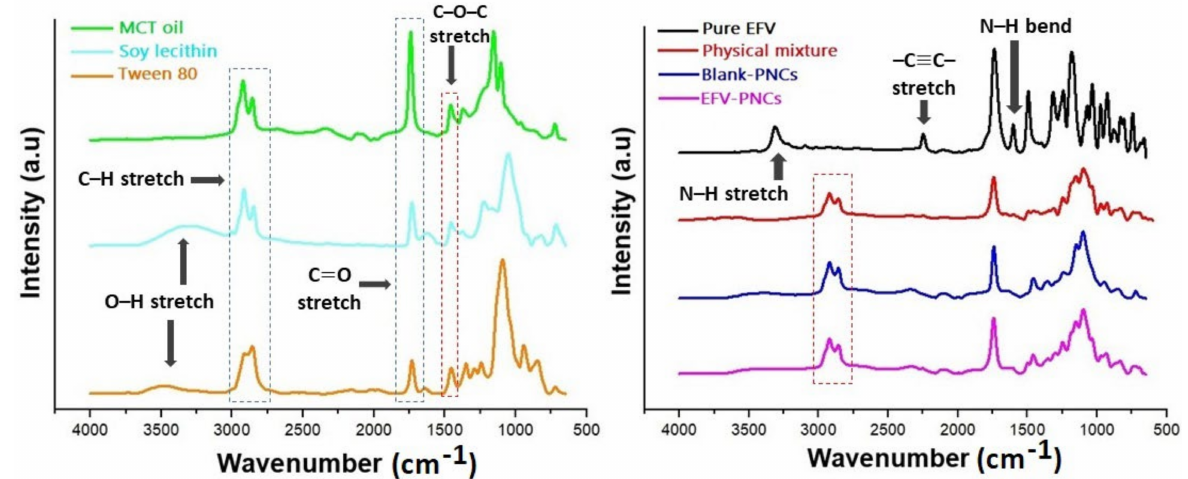
Figure 8. FTIR spectra of LNC formulations and raw materials.